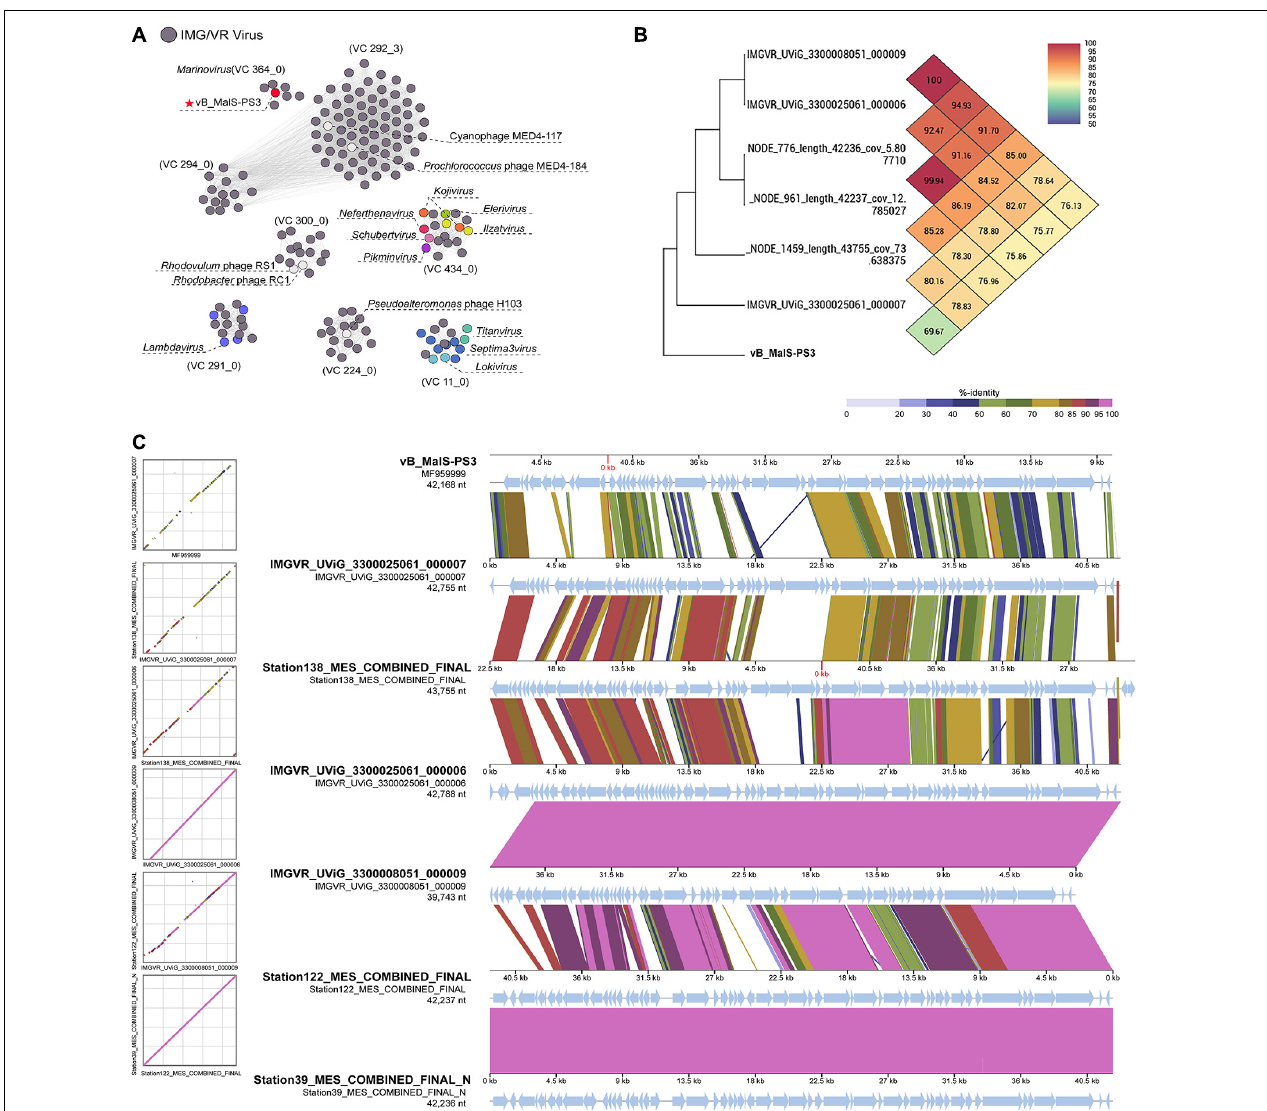
FIGURE 4 | (A) Gene-content-based viral network of vB_MalS-PS3, Siphoviridae virus from NCBI RefSeq database, and related environmental viral sequences from Integrated Microbial Genomes/Virus (IMG/VR). The nodes represent the viral genomic sequences. The edges represent the similarity score between genomes based on shared gene content. The gray circles indicate the related environmental viral sequences from IMG/VR. In each viral cluster (VC), viral genomes that belong to different genus clusters classified and ratified by the International Committee on Taxonomy of Viruses (ICTV) are indicated by different colors. VCs generated using vConTACT2, the network was visualized using Gephi version 0.9.2. (B) Genome comparison between the vB_MalS-PS3 and the environmental viral sequences in IMG/VR. (C) Heat map based on OrthoANI values calculated using OAT software.